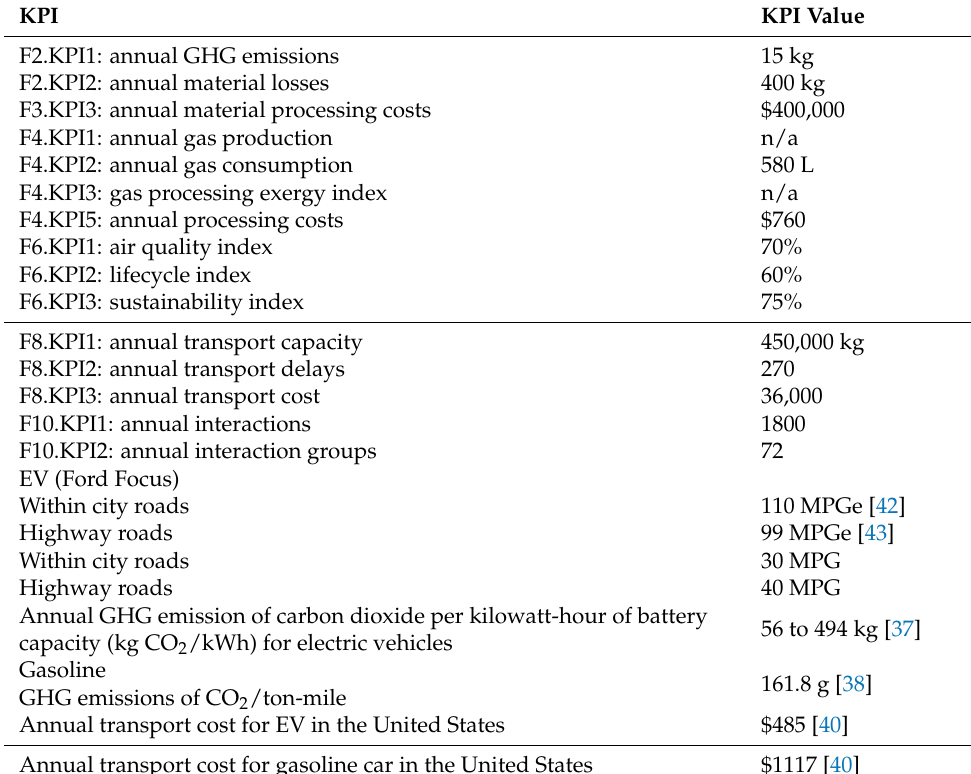
Table 6. Scenario variations based on selected options